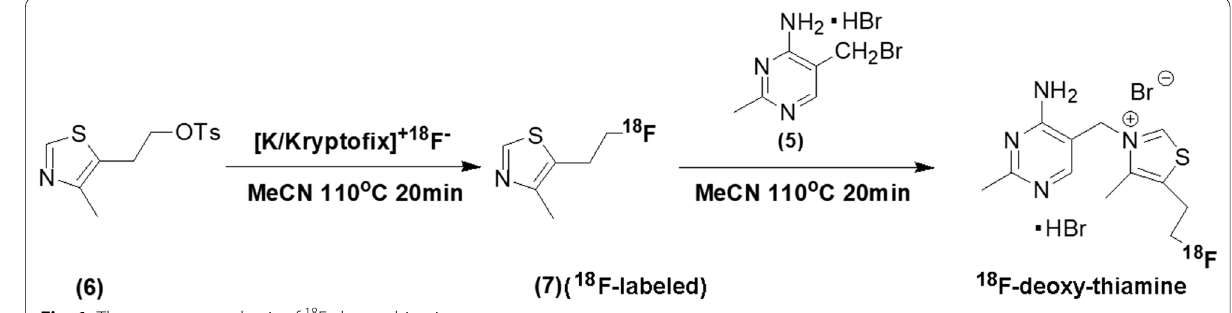
Fig. 1 The two-step synthesis of 18